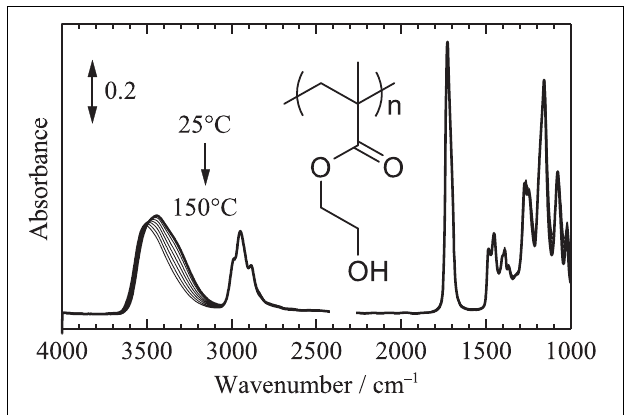
FIGURE 1 | Temperature-dependent IR spectra of PHEMA in the range of 25–150 ◦ C measured with an increment of 1 ◦ C (all the spectra are not shown here). Bold line corresponds to the spectrum at 25 ◦ C.